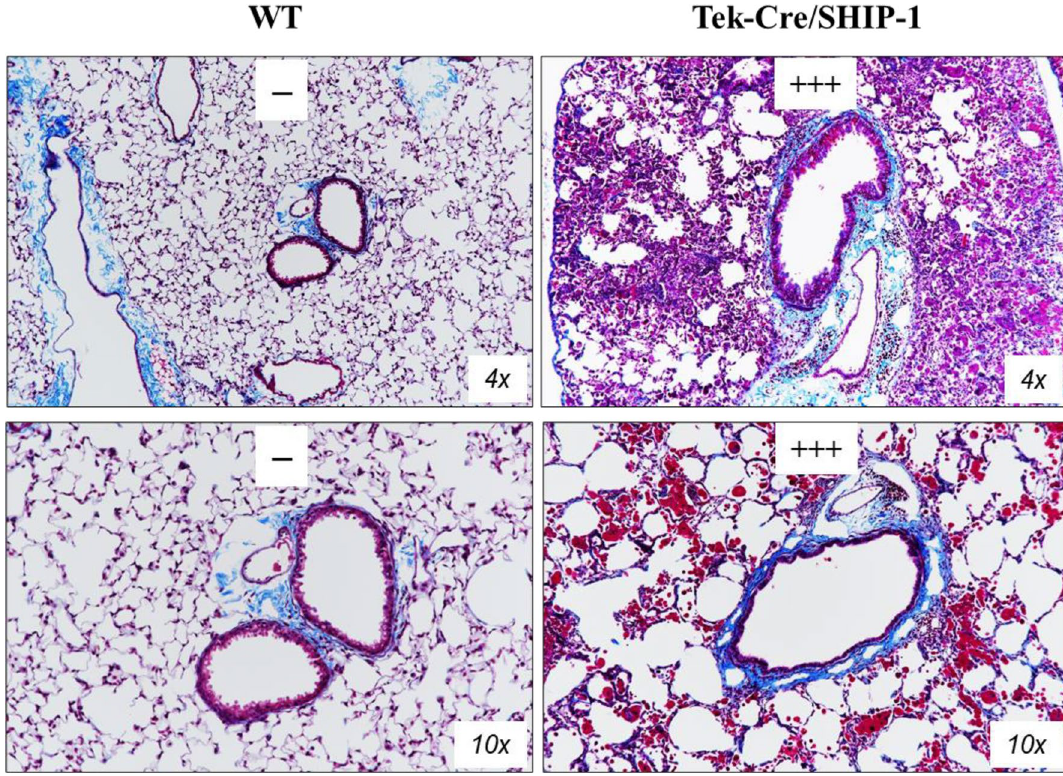
Figure 5. Pulmonary fibrosis in Tek-Cre/SHIP-1 mice. Masson’s trichrome staining of lung sections from WT and Tek-Cre/SHIP-1 mice are shown (n = 4 in each group). Pathology scores were assigned by a pathologist and through application of the ImageJ software and its associated color deconvolution